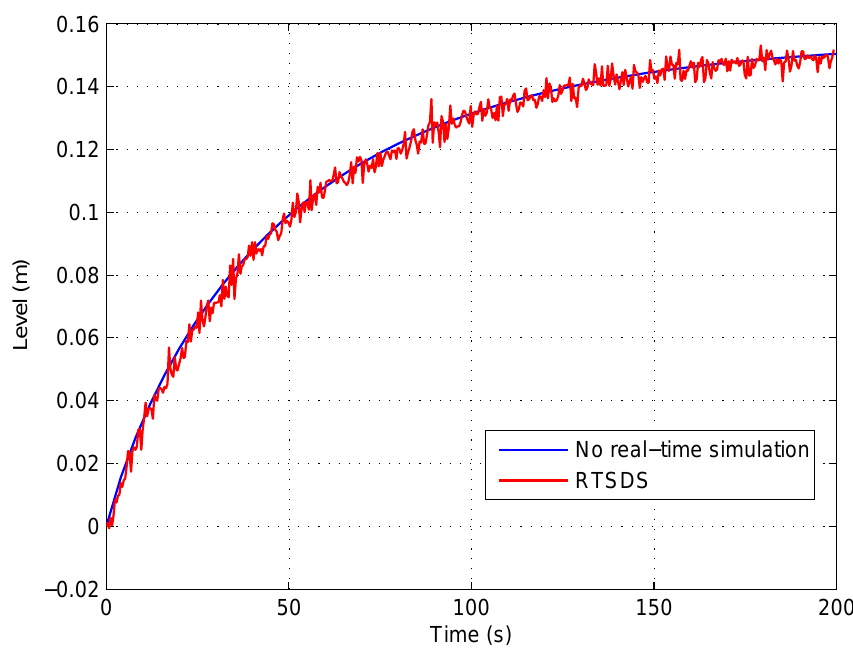
Figure 17. Results obtained for the RTSDS platform applied to the dynamic system characterized by Equation (5), with A = 62 . 072 cm 2 and q